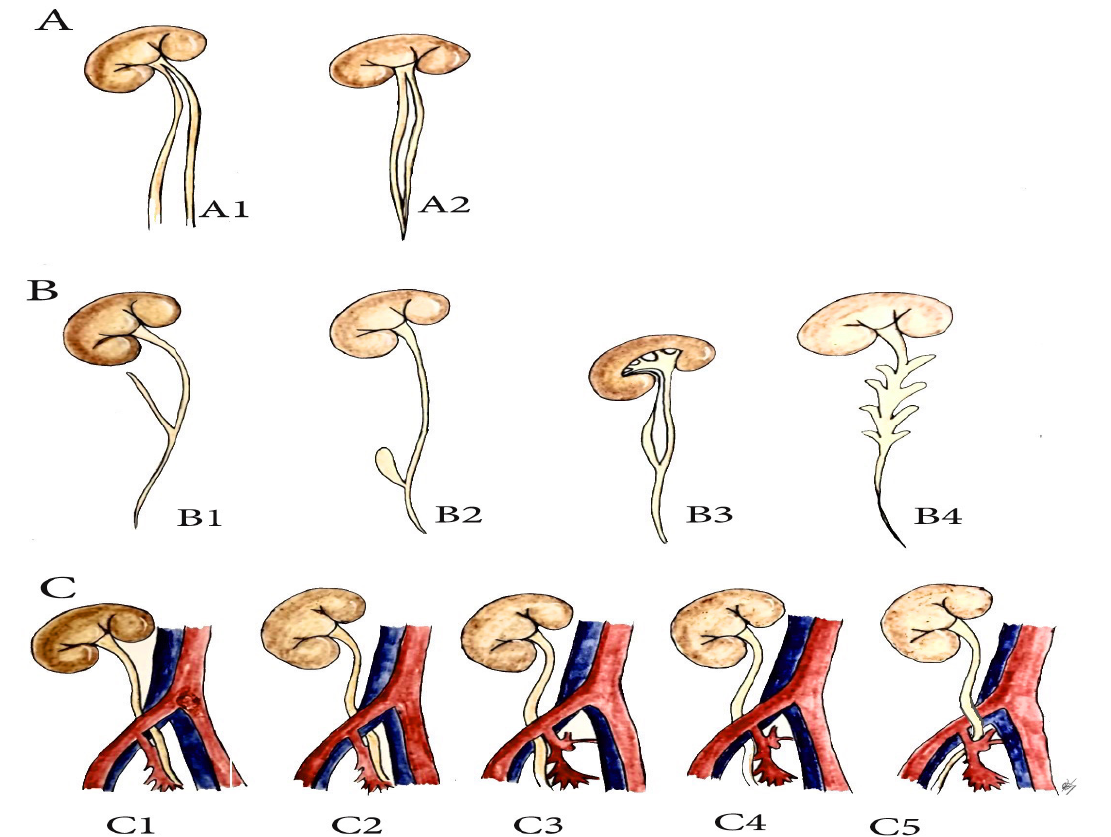
Figure 6. Anatomical variations of the ureter related to pelvic lymph node dissection in gynecologic oncology (PLNDGO). ( A ) Duplicated ureter. ( A1 ) complete duplication. ( A2 ) incomplete duplication. ( B ) Ureteral diverticulum (Adapted from Papin and Eisendrath [29]). ( B1 ) simple diverticulum, ( B2 ) ampullary diverticulum, ( B3 ) diverticulum ending in fibrous prolongation, ( B4 ) multiple diverticulus. ( C ) Retroiliac ureter. ( C1 ) Behind the common iliac artery, ( C2 ) behind the common iliac vein, ( C3 ) behind the external iliac artery, ( C4 ) behind the external iliac vein, ( C5 ) behind the internal iliac artery.